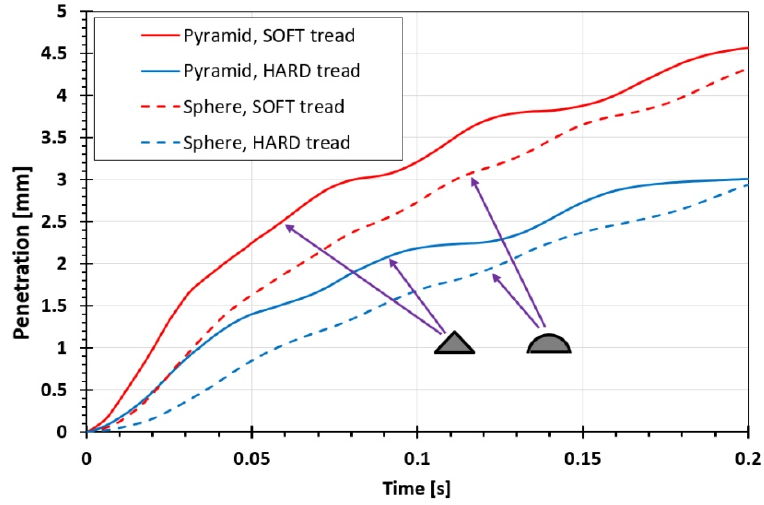
Figure 14. Deflection of tire tread by penetrators of different